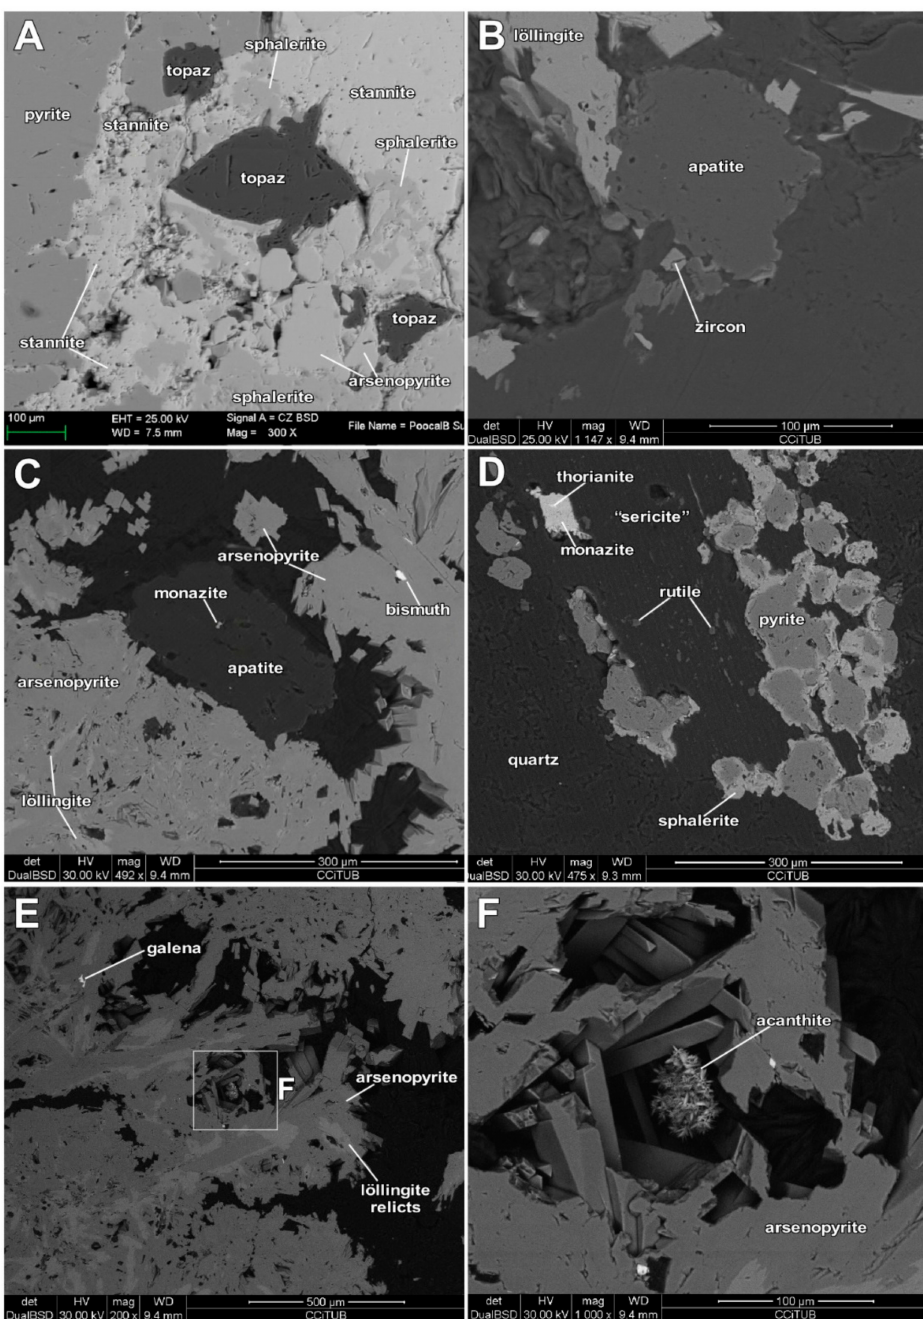
Figure 5. Back-scattered electron images of early mineralisation (Stage 1) in the Poop ó deposit. ( A ) Early arsenopyrite followed by topaz and pyrite, and by a close association between sphalerite and stannite that formed reactively at the expense of pyrite; sample from the Calaveras section. ( B ) Apatite and zircon in close association with early löllingite. ( C ) Monazite enclosed in apatite in close association with löllingite, the latter having been almost entirely replaced by arsenopyrite. ( D ) Thorianite enclosed in monazite, in association with pyrite that was partly replaced by sphalerite. ( E ) Similar association to C, in which arsenopyrite and galena replaced löllingite, that remains as relicts. ( F ) Inset from E that shows late micro-aggregates of acanthite crystals in cavities; it is uncertain whether these formed before or after the replacement of löllingite by